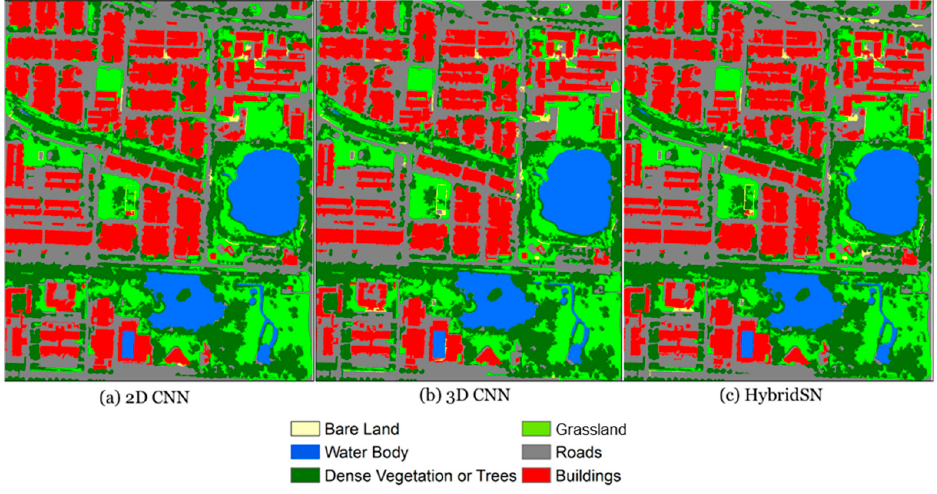
Figure 6. Classification maps of different CNN methods for the training area: ( a ) 2D CNN, ( b ) 3D CNN, and ( c ) HybridSN.